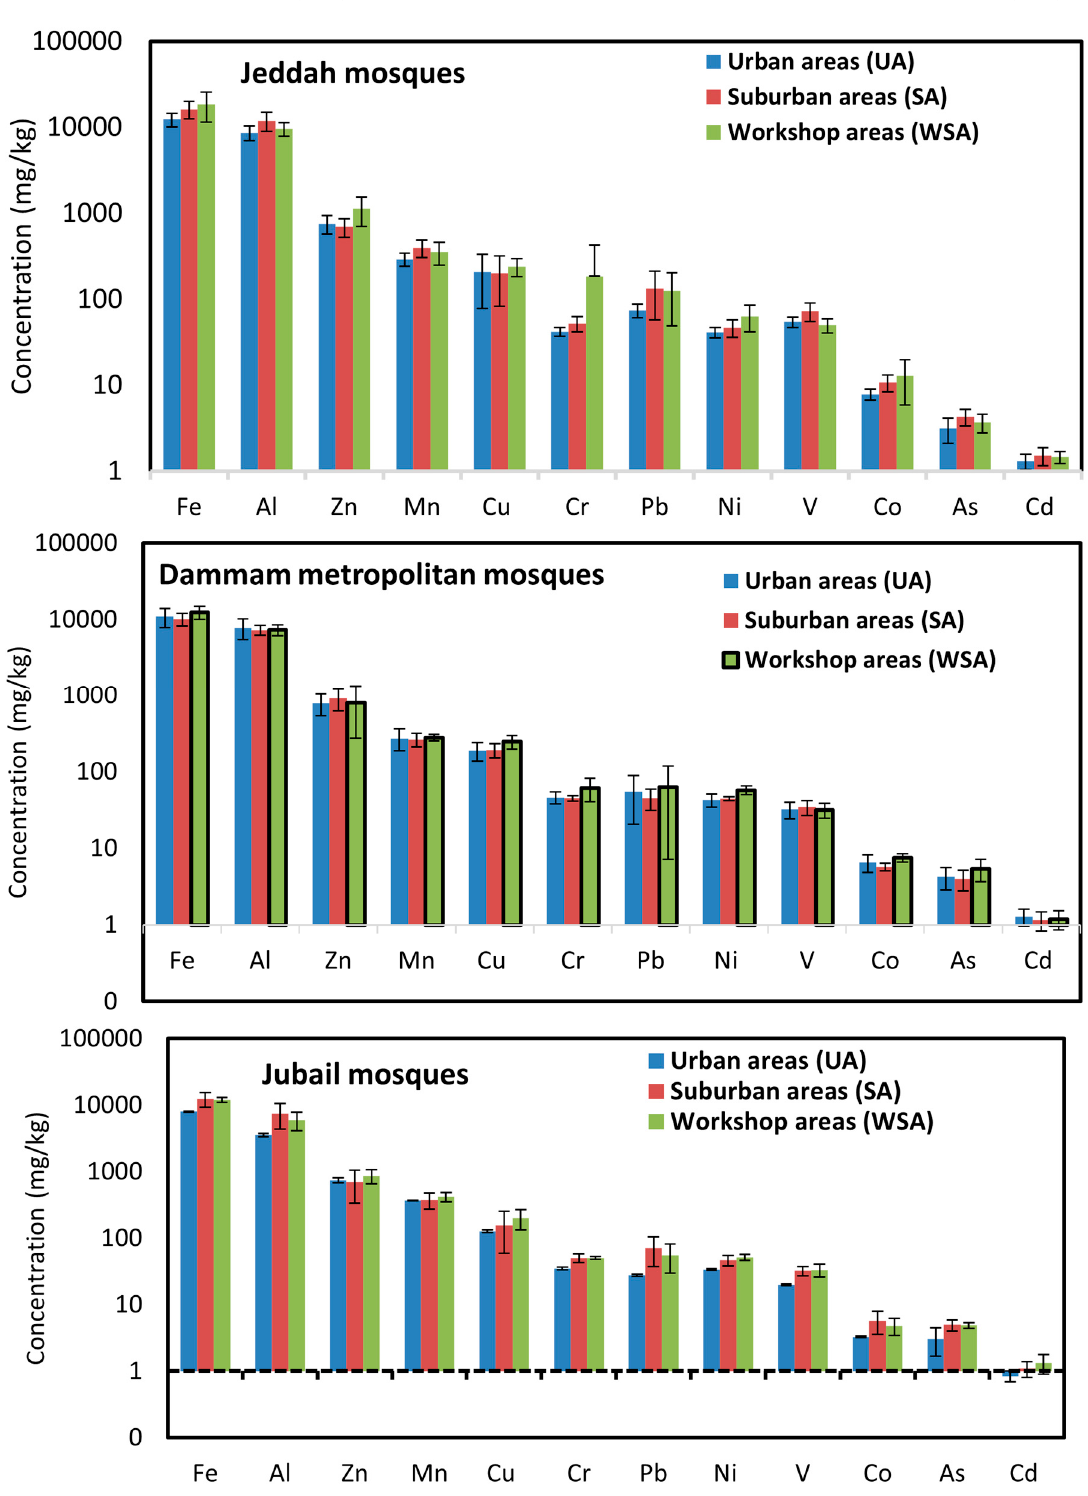
Figure 2. The concentrations of PHEs in ACFD of mosques located in different cities are based on function areas (urban areas-UA; suburban areas-SA; workshop areas-WSA).